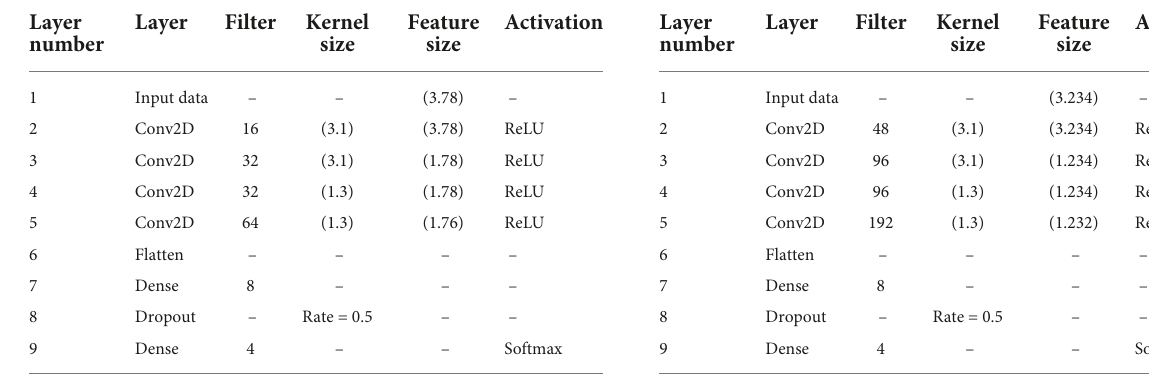
TABLE 1 Single-person convolutional neural network structure. TABLE 3 Two-person serial feature connection CNN